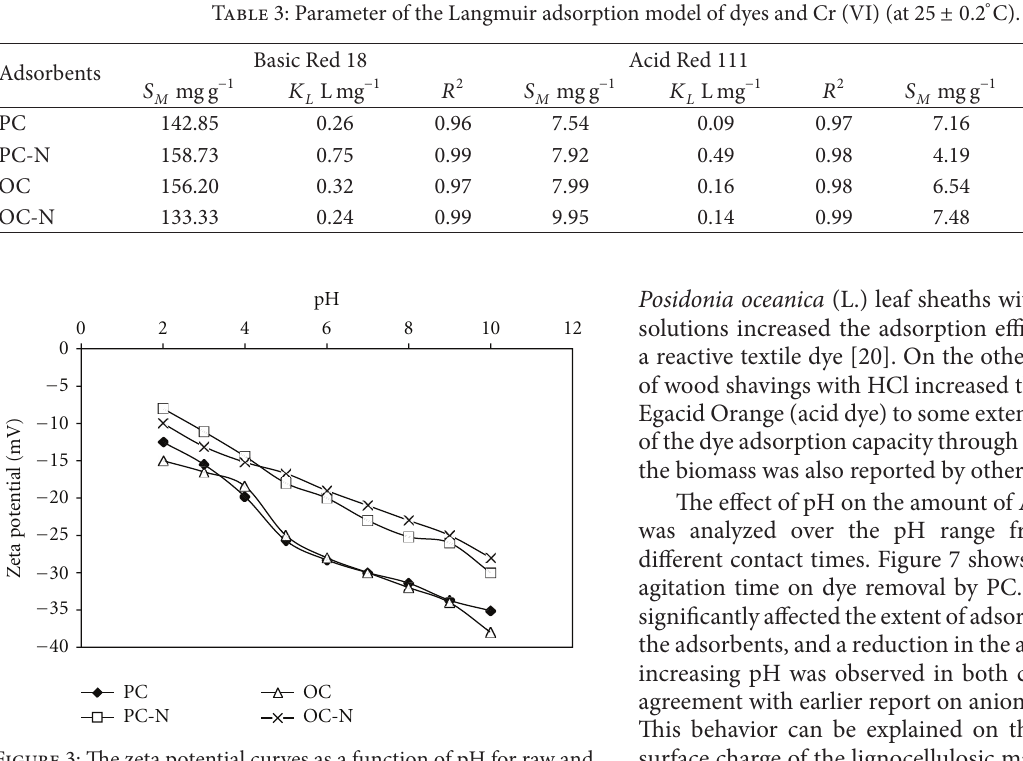
F 3: e zeta potential curves as a function of pH for raw and modi�ed PC and